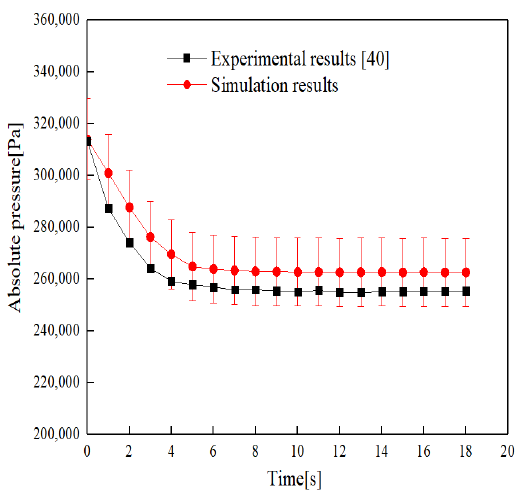
Figure 7. Verification of the sloshing model with a phase change.